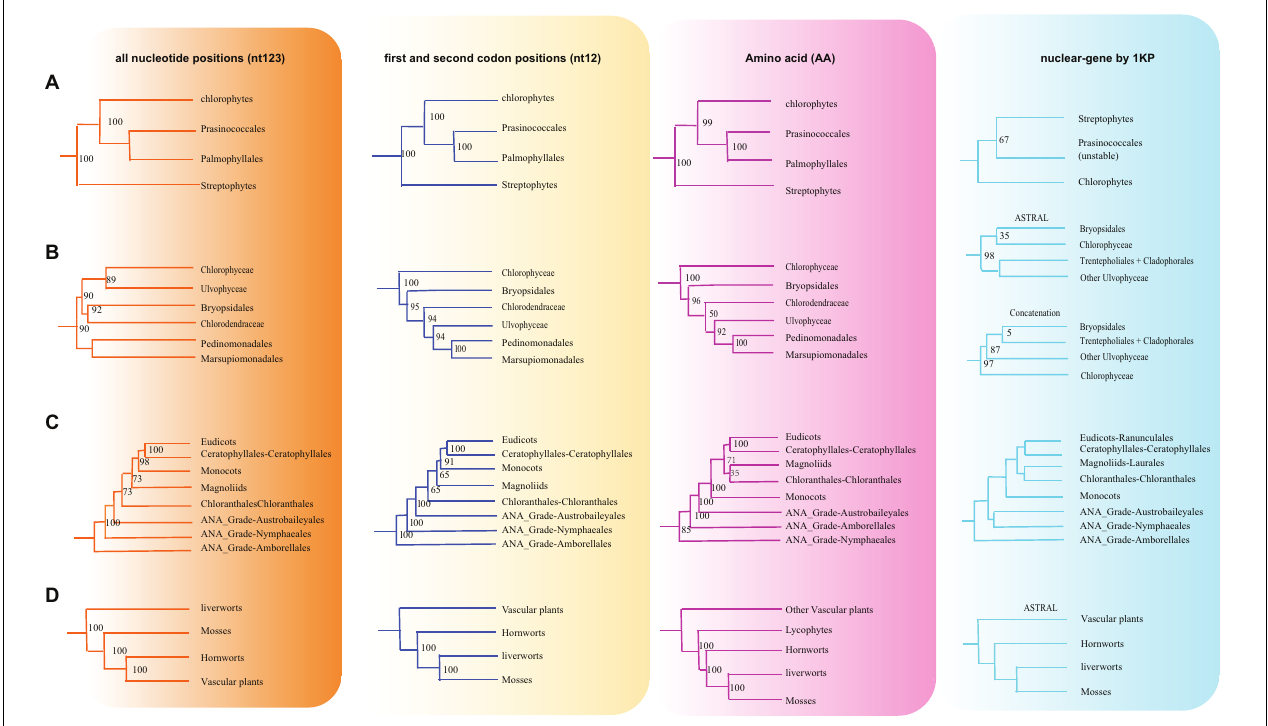
FIGURE 5 | Various branching orders for the phylogenetically discordant relationships. (A) Early Viridiplantae diversification, (B) early diversification of green algae, (C) the lineages of angiosperms, (D) early embryophyte diversification. The summarized topology is based on three data sets (nt12, nt123, and AA) of 72 protein-coding genes of 3,654 green plants and six Rhodophyta using IQTREE, including 1KP data set (nuclear gene-based).